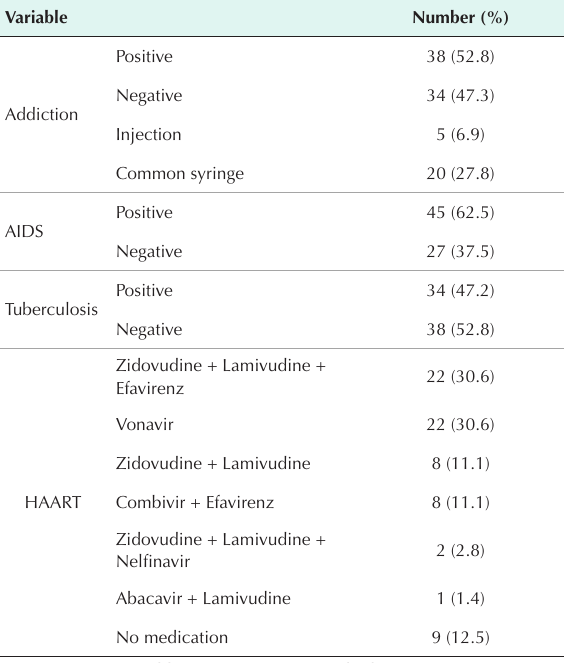
Table 1. Frequency of Addiction, AIDS, History of Tuberculosis, and Type of HAART Treatment in HIV-positive Population Variable